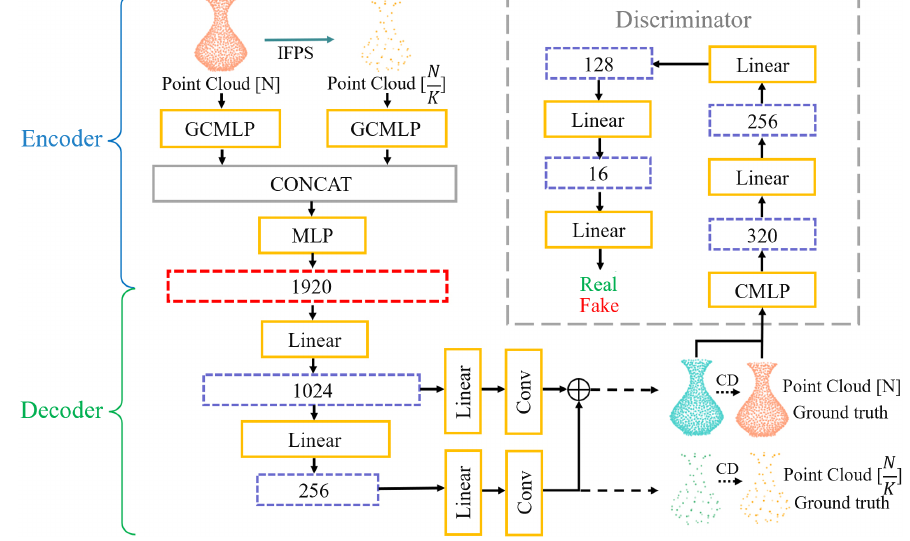
Figure 5. Overall structure of GN-GAN.